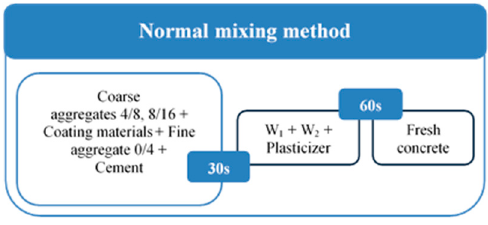
Figure 2. Experimental normal mixing